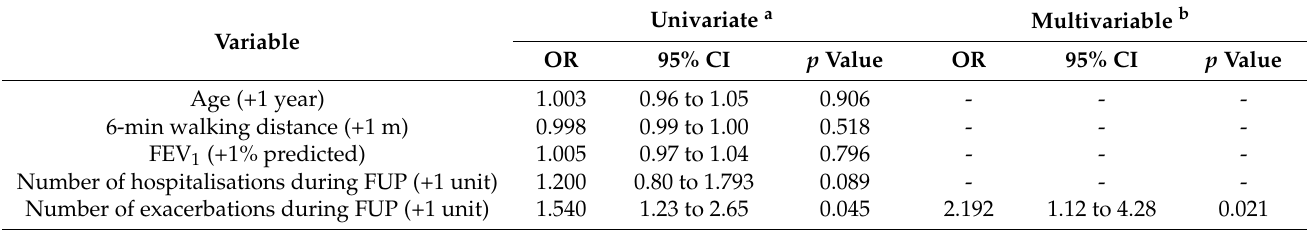
Table 3. Significant risk factors for inactivity and sedentary behaviour in the logistic regression